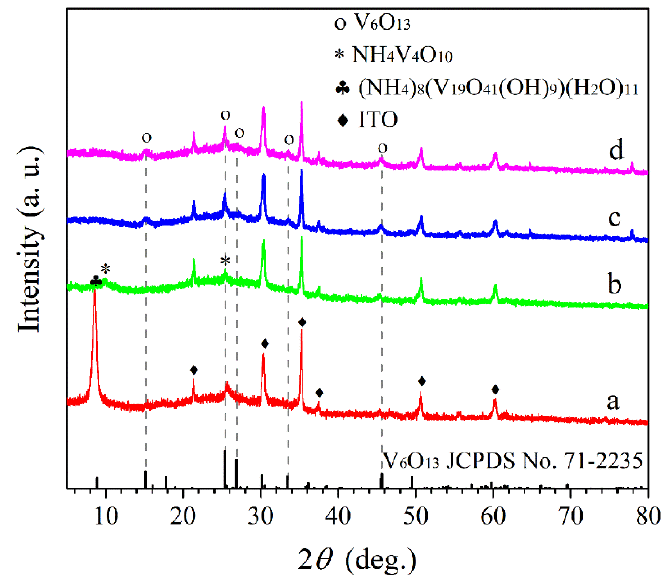
Figure 1. XRD patterns of films: the deposited film (a); N − 350 (b); N − 400 (c); N − 450 (d).